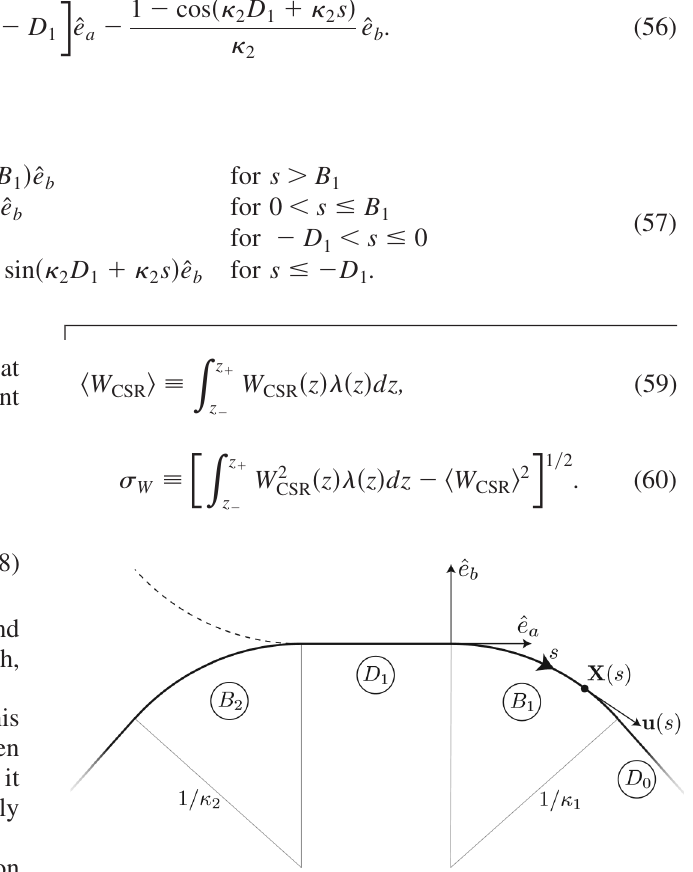
FIG. 10. Geometry for bends and drifts. The variable s pa- rametrizes the path X ð s Þ , with s ¼ 0 at the beginning of element B . The names B , D , etc. also serve to indicate the element 1 1 1 length. The dashed line is for a prior bend with negative curvature.